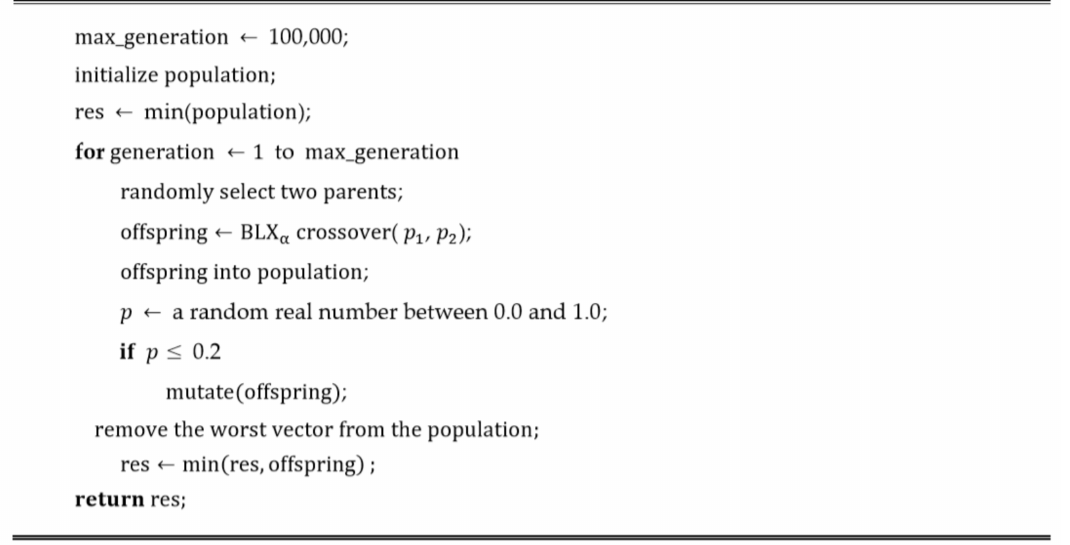
Figure 3. Pseudocode of the proposed genetic